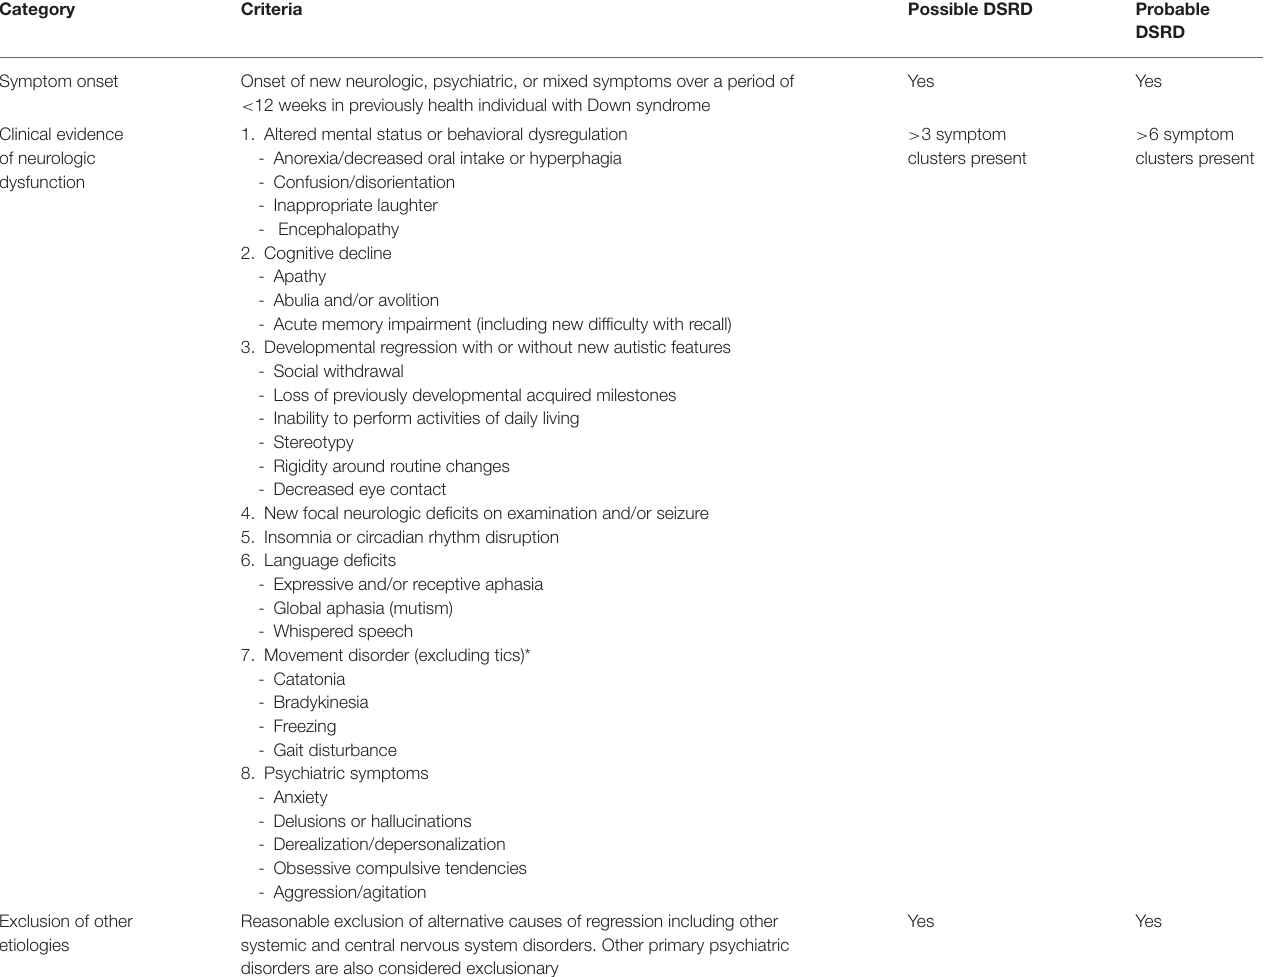
TABLE 4 | Consensus recommendations for the diagnosis of Down syndrome regression